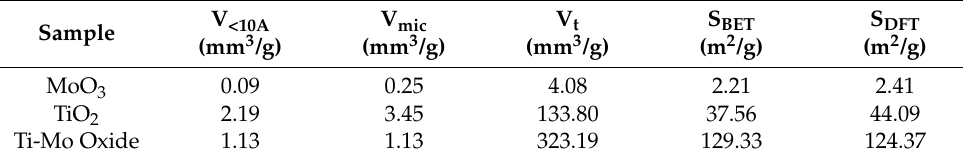
Table 1. Surface Structural Parameters.